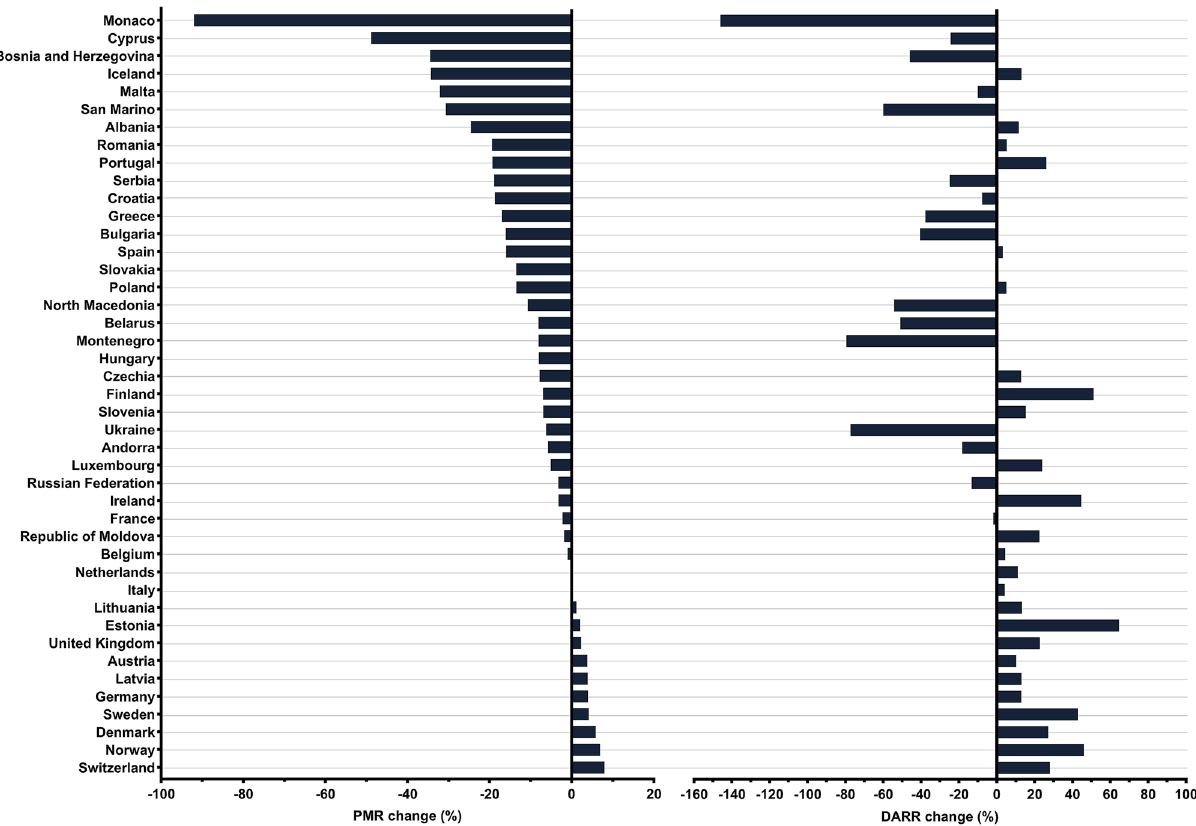
Figure 5. DARR change (%) and PMR change (%) for European countries.